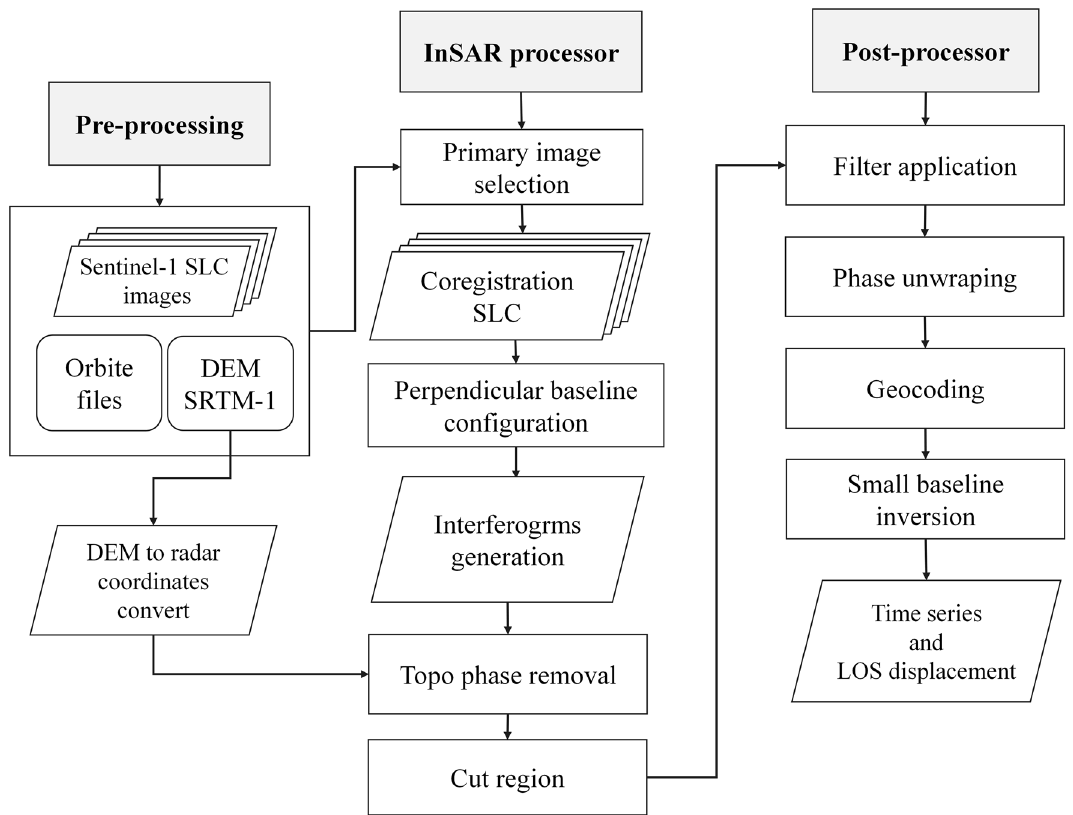
Figure 9. Flowchart of the SBAS-InSAR technique by GMTSAR used in this